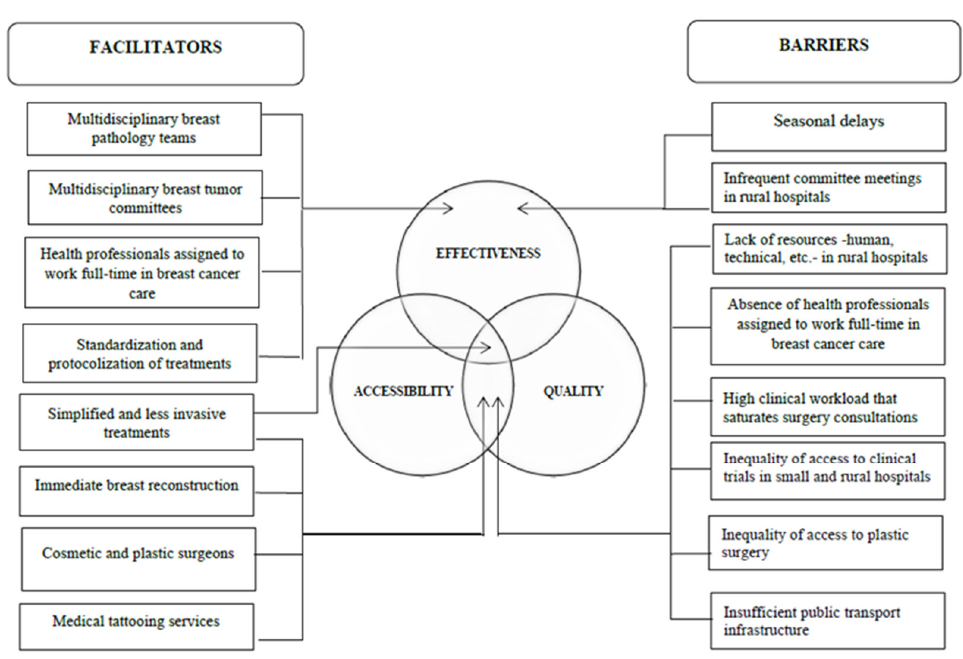
Figure 1. Barriers and facilitators in breast cancer treatment.